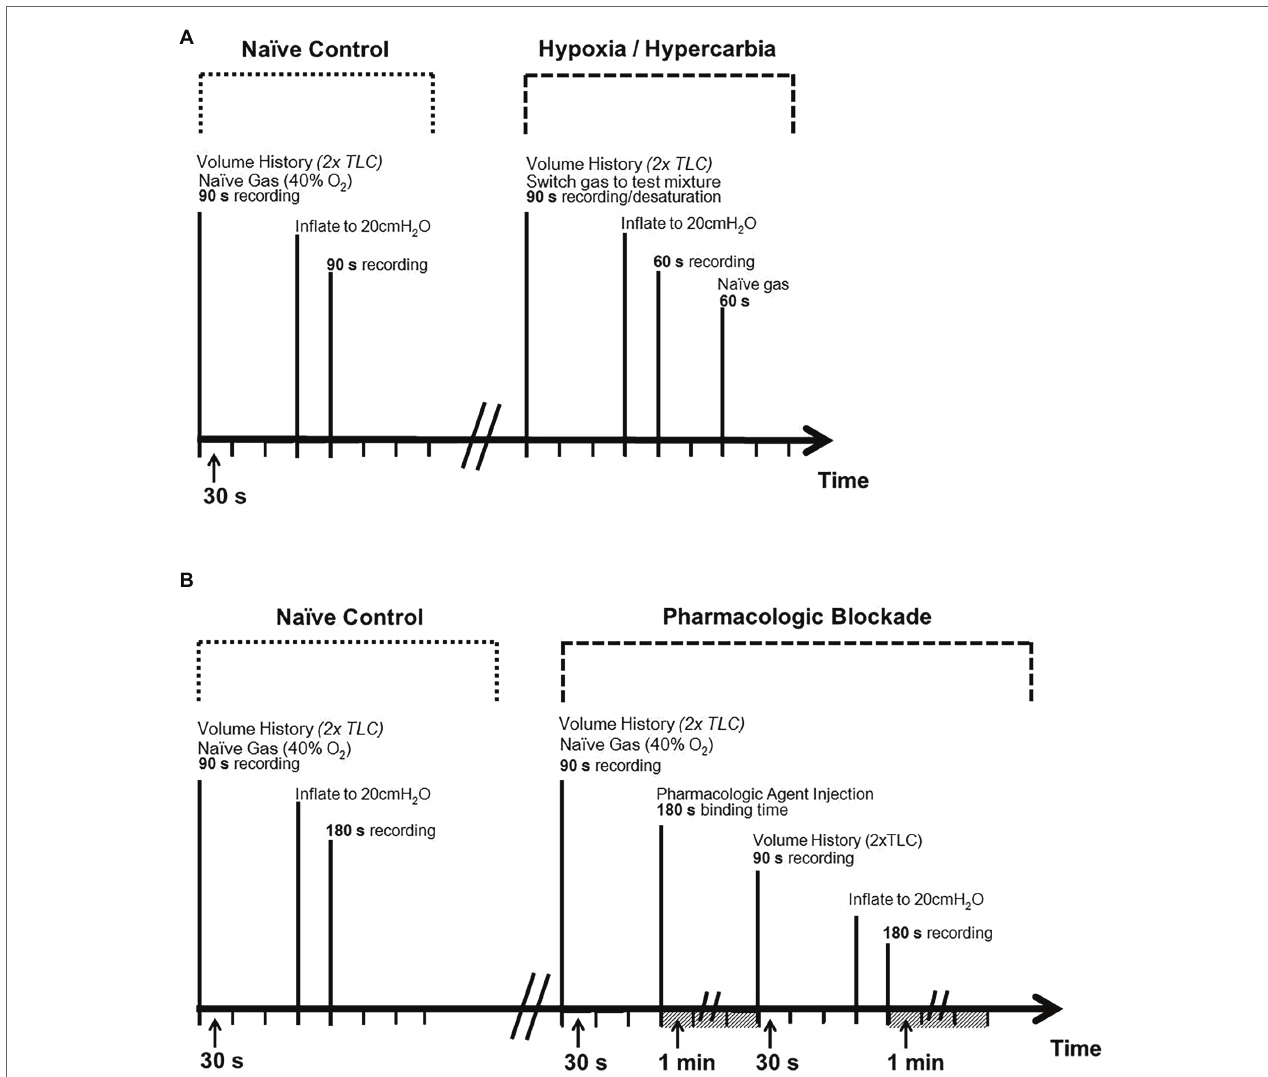
FIGURE 3 | Experimental protocol timelines. Top panel (A) : timeline for chemosensory challenges (hypoxia and hypercarbia). Bottom panel (B) : timeline for pharmacologic challenges [serotonergic (Tropisetron) and purinergic (Suramin) blockade]. Volume history consisted of two hyperinflations to total lung capacity (TLC) prior to experiment to ensure standardized pulmonary compliance between trials.